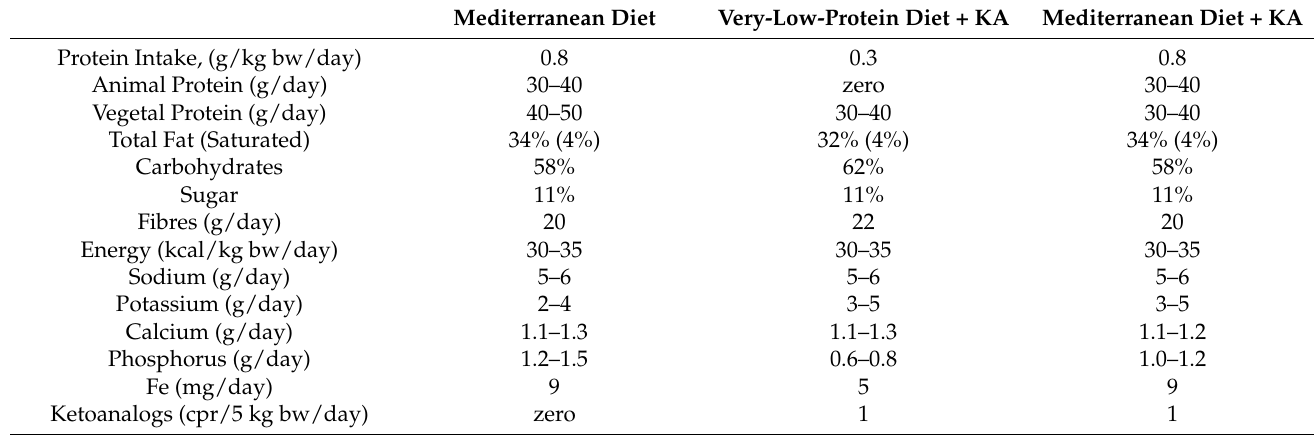
Table 1. Diets’ composition [8,16].